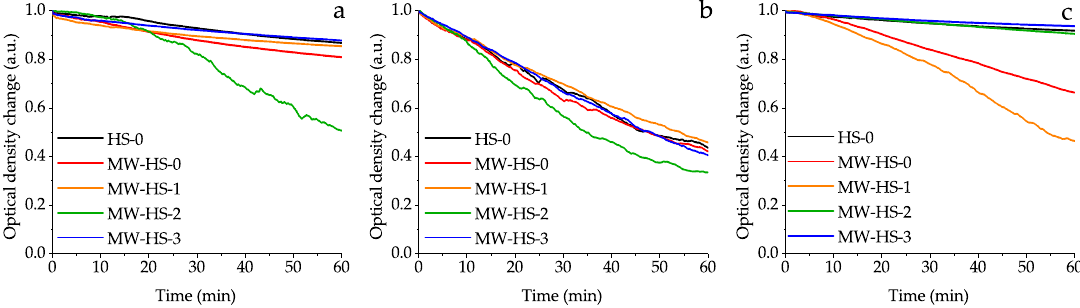
Figure 7. Optical density changes at the wavelength 600 nm for the iron oxide colloids in: ( a ) deionized water; ( b ) normal saline solution; ( c ) model infusion